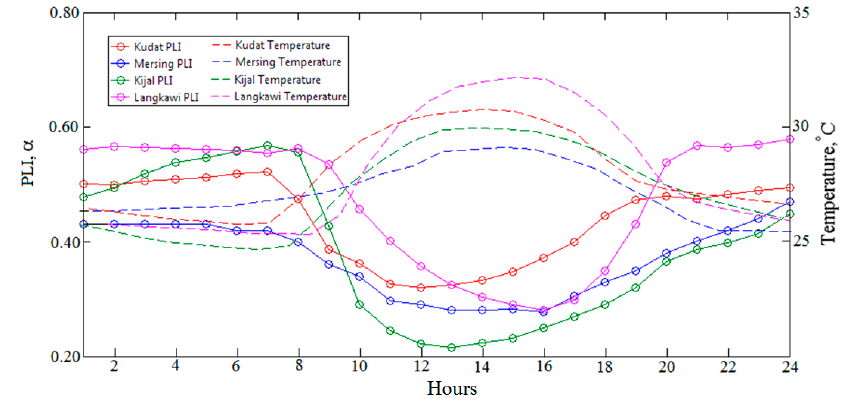
Figure 5. The diurnal variation of PLI at different sites.